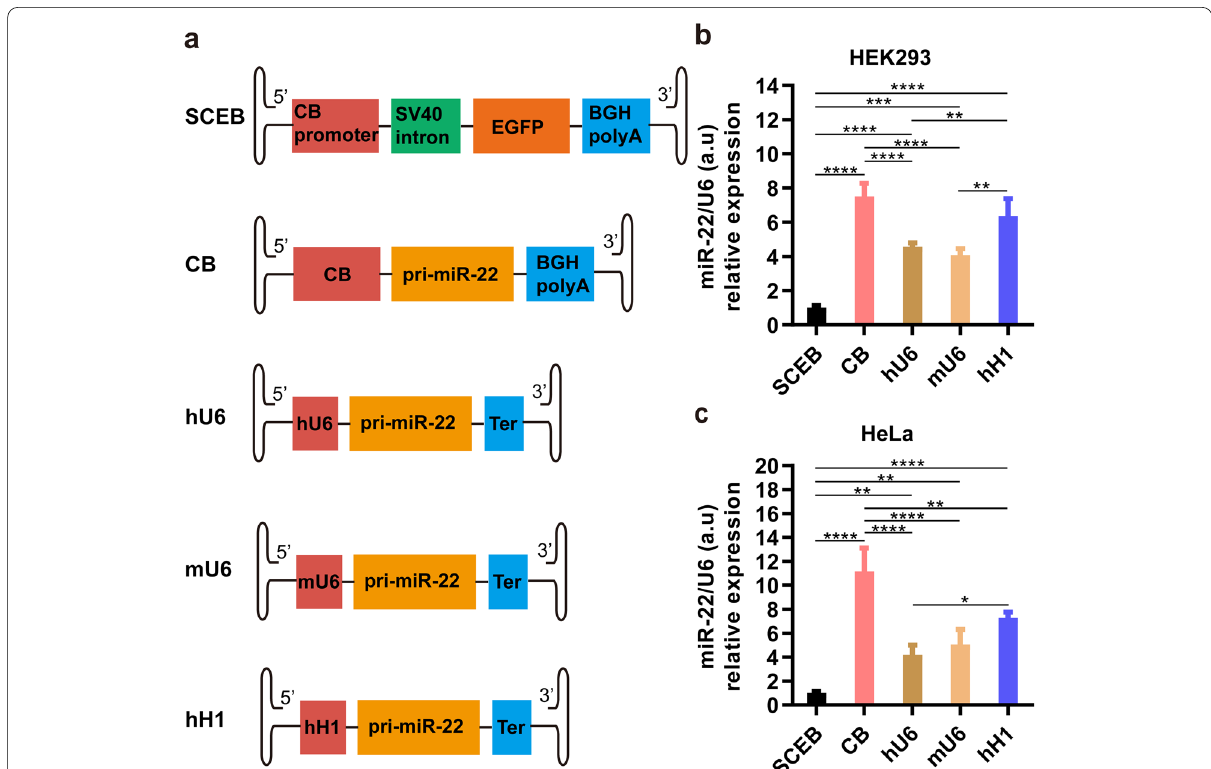
Fig. 2 miR-22 expression comparisons driven by the Pol II promoter (CB) and Pol III promoters (hU6, mU6, and hH1). a Schematic pictures of miR-22 expression cassettes in the rAAV vector plasmids with different promoters. CB, chicken β-actin promoter with CMV enhancer; hU6, human U6 promoter; mU6, mouse U6 promoter; hH1, human H1 promoter; Ter, TTT TTT sequence, the termination signal for miRs. b miR-22 expression levels driven by different promoters in HEK293 cells. c miR-22 expression levels driven by different promoters in HeLa cells. n standard deviation of the mean. * P < 0.05, ** P < 0.01, *** P < 0.001, and **** P <